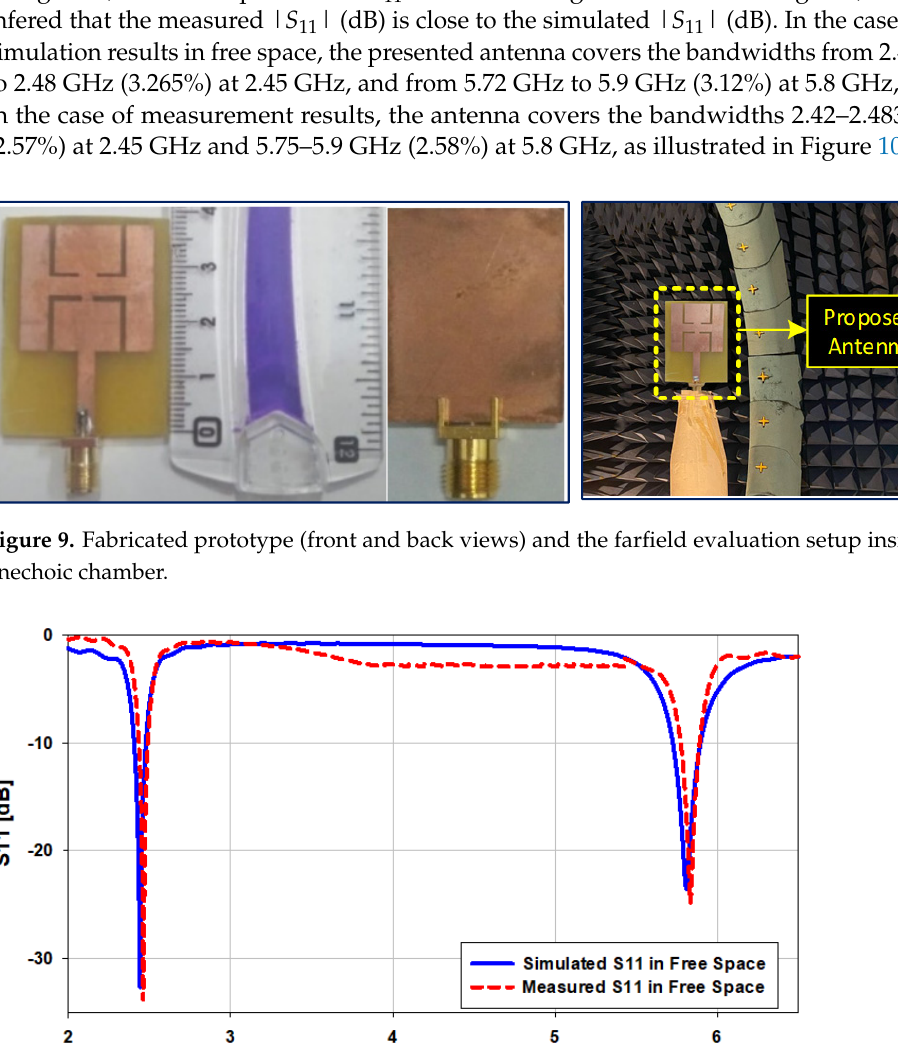
11 in free space.